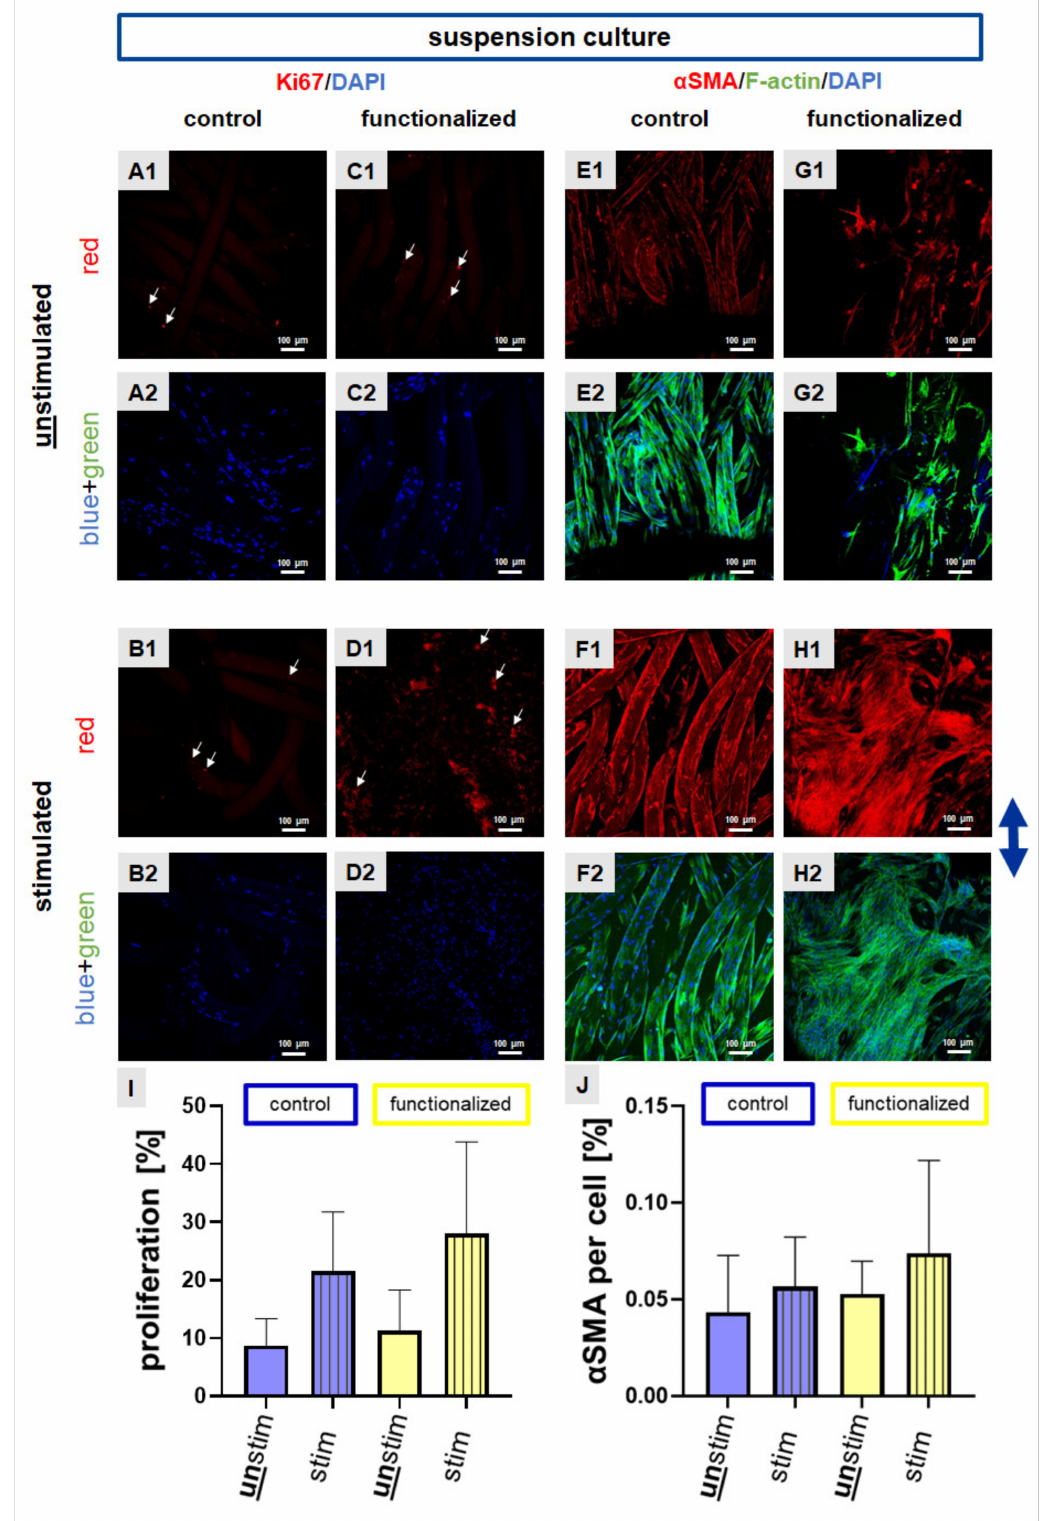
Figure 4. Ki67 and α SMA protein expression in scaffolds seeded with the suspension culture. Suspension pre-culture was performed for 24 h dynamically. Immunocytochemical staining of Ki67 (red) was performed for control ( A , B ) and func- tionalized scaffolds ( C , D ). Immunocytochemical staining of the myofibroblast marker α -smooth muscle actin ( α SMA, red) combined with F-actin staining (green) was performed for control ( E , F ) and functionalized scaffolds ( G , H ). Unstimulated ( A , C , E , G ) scaffolds were compared with stimulated (72 h, 4% stretch, 0.11 Hz, ( B , D , F , H )). The proliferation rate ( I )